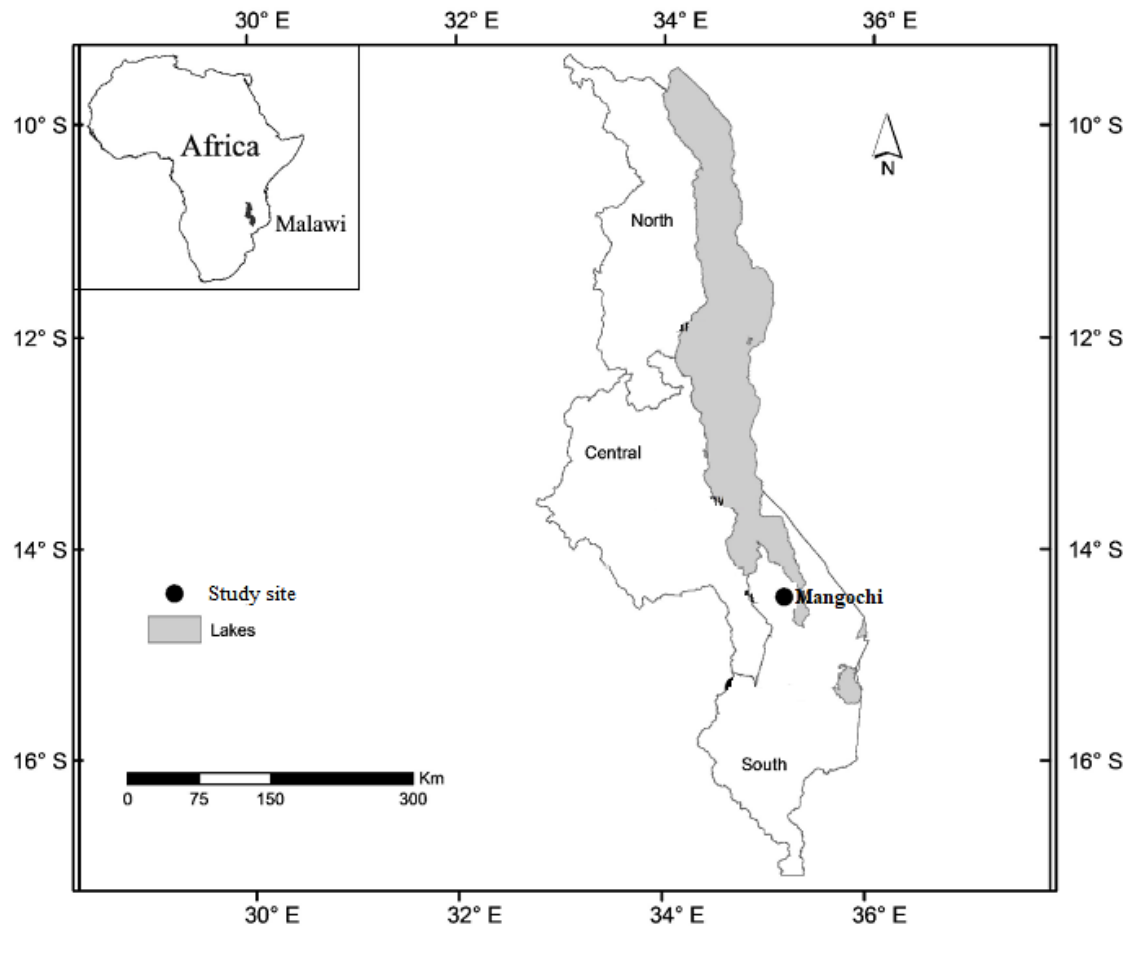
Figure 1. Map of Malawi showing the location of the study